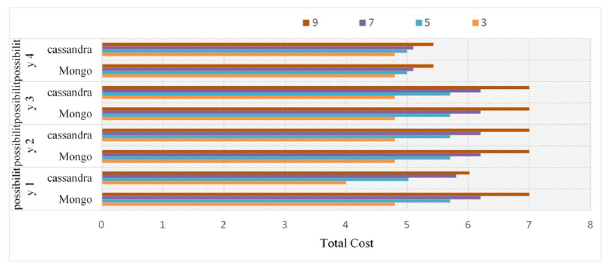
Fig 20. Performance variables for Cassandra compared with those for MongoDB on linear joins.